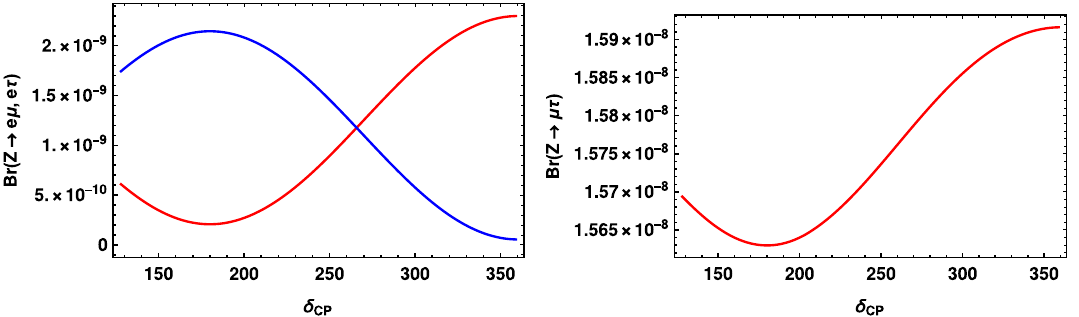
Fig. 2 Plots between m k (cid:12) and λ 5 . Red, blue and green lines are for m 1 (cid:12) k right-hand side plots are for NO and IO respectively. In both the plots, we have taken m 0 = 150 GeV, M 1 = 100 GeV, M 2 = M 1 + 50 GeV and M 3 = M 2 + 50 GeV